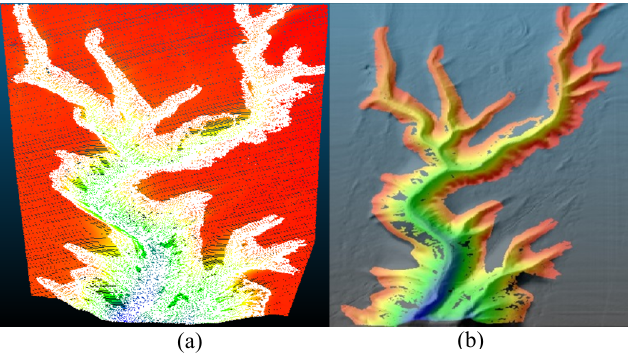
Figure 9. The verification of results for point cloud segmentation: (a) the overlay of raw point cloud and the point cloud of segmentation. (b) the overlay of DEM and the point cloud of